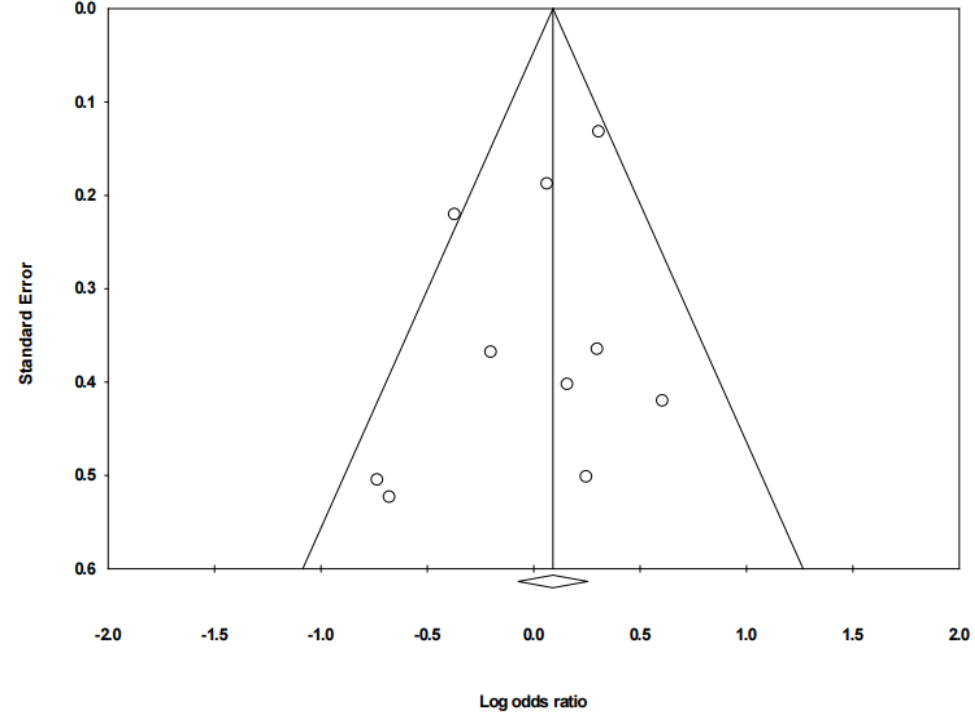
Figure 4. Funnel plot of included articles.